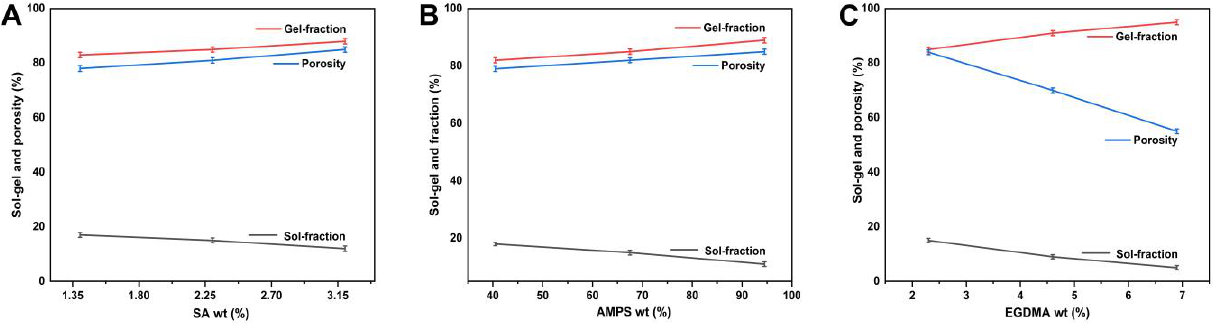
Figure 6. Effect of sodium alginate ( A ), AMPS ( B ), and EGDMA ( C ) on sol–gel fraction and porosity of fabricated hydrogels.